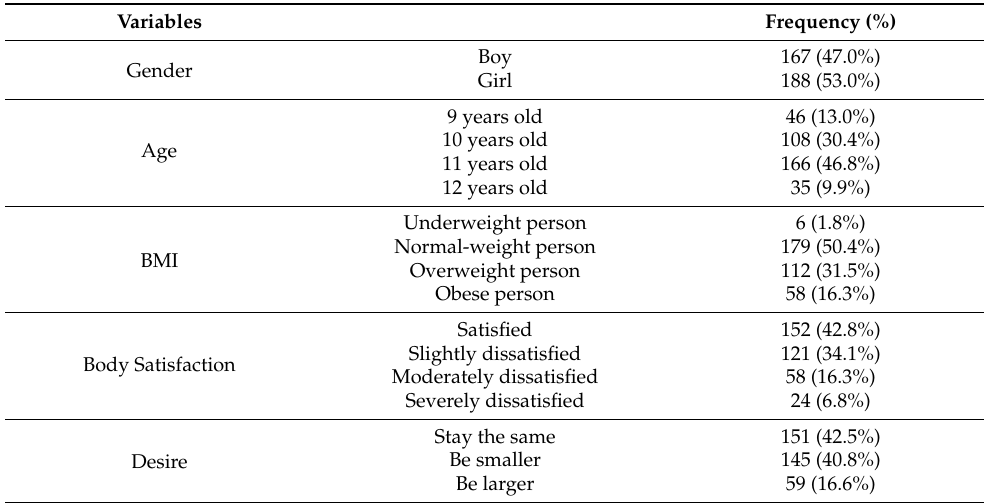
Table 1. Sample characterization.